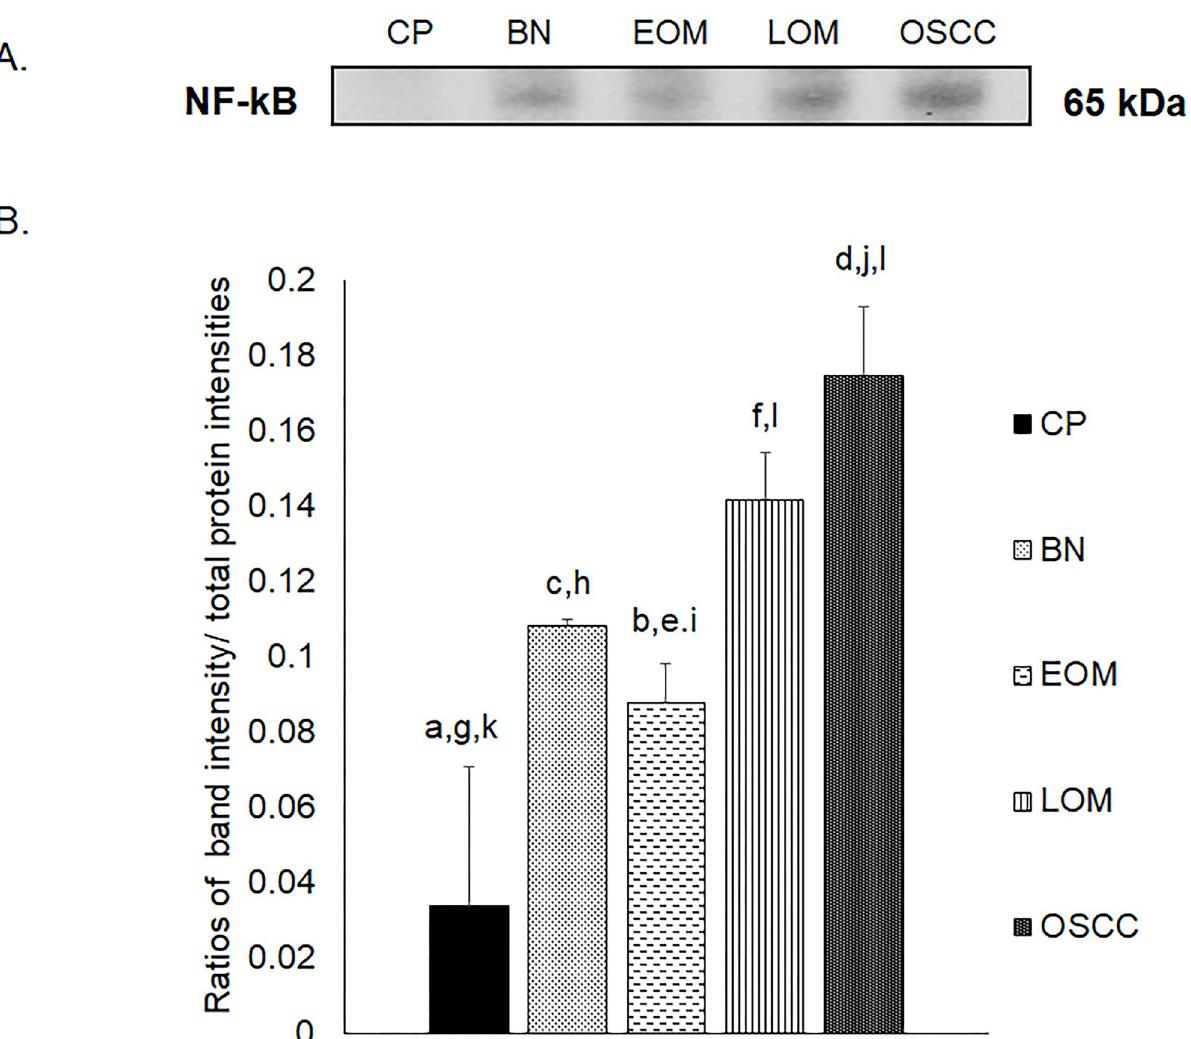
Fig 10. Western blot analysis of nuclear factor kappa B (NF- κ B) of pooled saliva samples from dogs with benign oral tumors (BN), early- and late-stage oral melanoma (EOM and LOM, respectively), oral squamous cell carcinoma (OSCC) and periodontitis and normal controls (CP). Representative western blot for NF- κ B at 65 kDa (A) and bar graph of ratios of NF- κ B protein intensity to total blotted proteins in each lane in the first half of a membrane � (B) . a–b, c–d and e–f denote a significant difference at p < 0.05. g–h and i–j denote a significant difference at p < 0.01. k–l denote a significant difference at p <